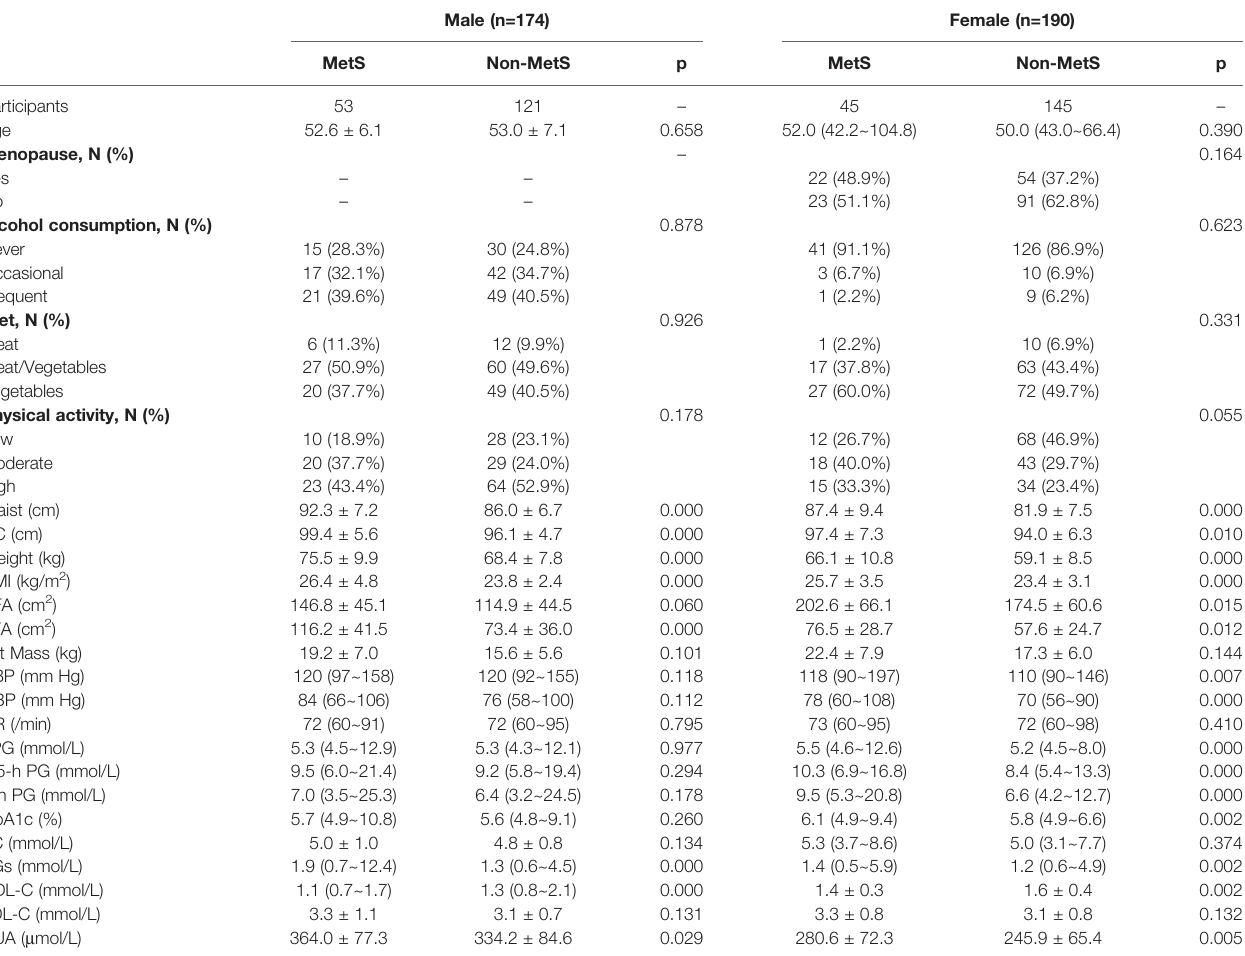
TABLE 2 | Incidence of MetS in the non-MetS population during 1.5 years of follow-up.